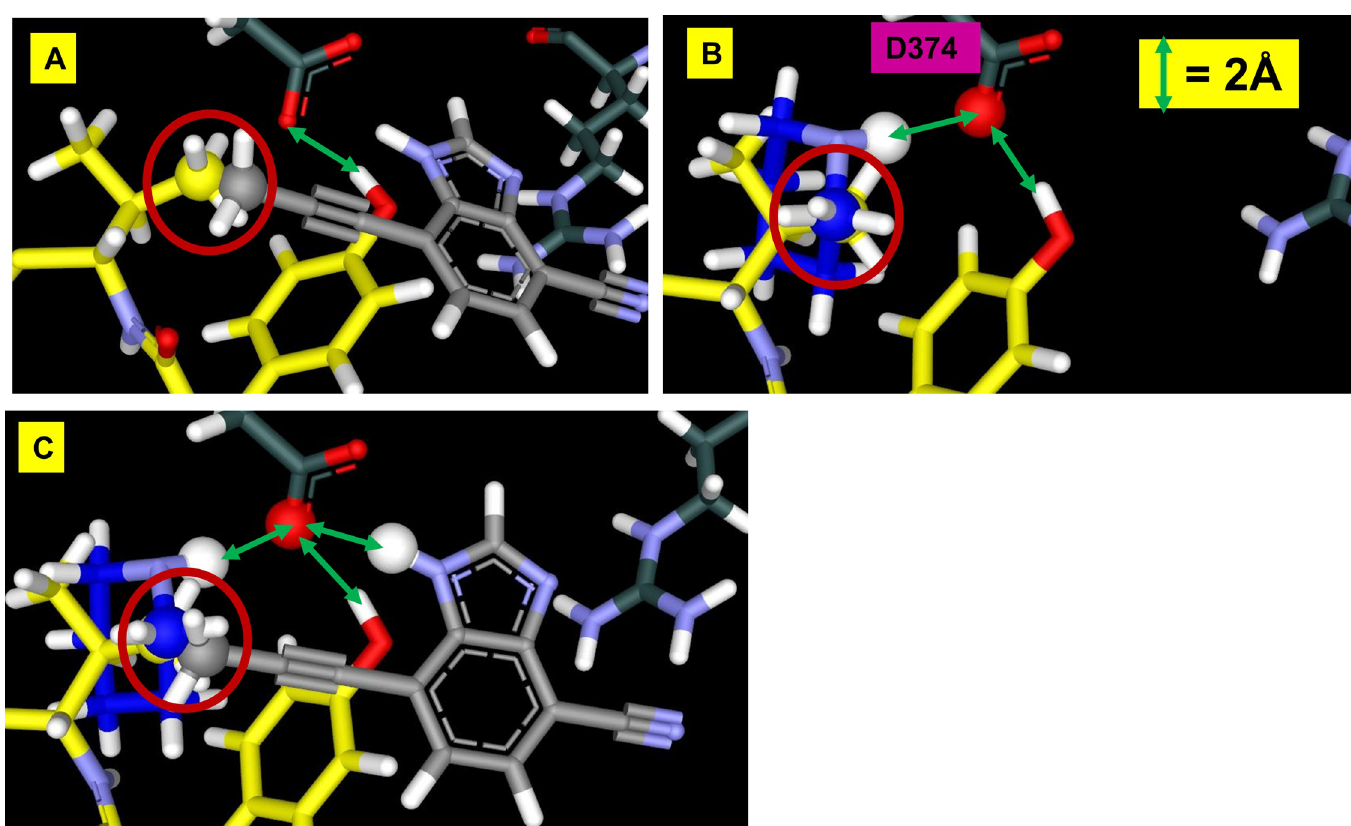
Fig 9. An acetylene linker is added to cyano-benzimidazole. A trial custom fragment was designed (A) and SACP confirmed that it tightly bound in the same mode as the original smaller fragment with the terminal carbon of the acetylene moiety occupying the same space as a terminal carbon of LDLR-Val307 (red ring). The piperidine fragment (B) binds with its carbons overlapping the side chain carbons of LDLR-V307 and pointing its N to form an H-bond with PCSK9-D374 and thus the two fragments (C) merge at LDLR-Val307 eliminating the error-prone linking